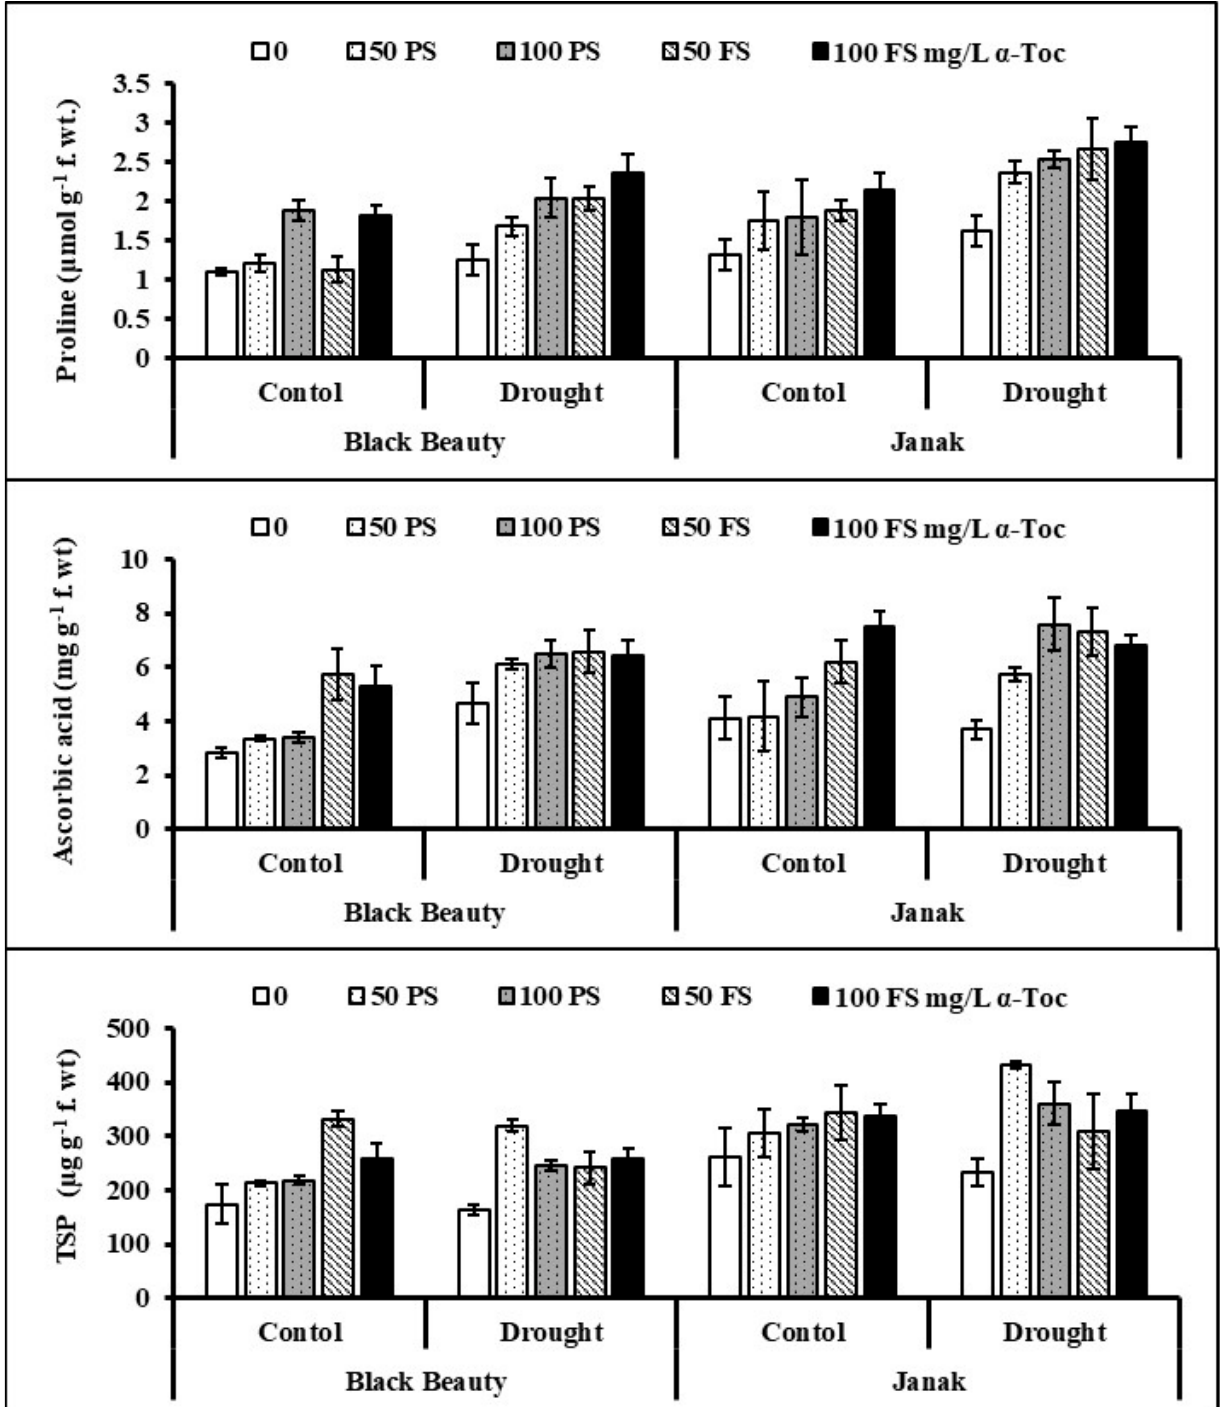
Figure 4. Leaf glycine betaine, proline, ascorbic acid, and total soluble protein (TSP) contents in two cultivars of eggplants subjected to exogenous TOC (pre-sowing (PS) and foliar spray (FS)) under varying water regimes (mean ± S.E.; n = 4).